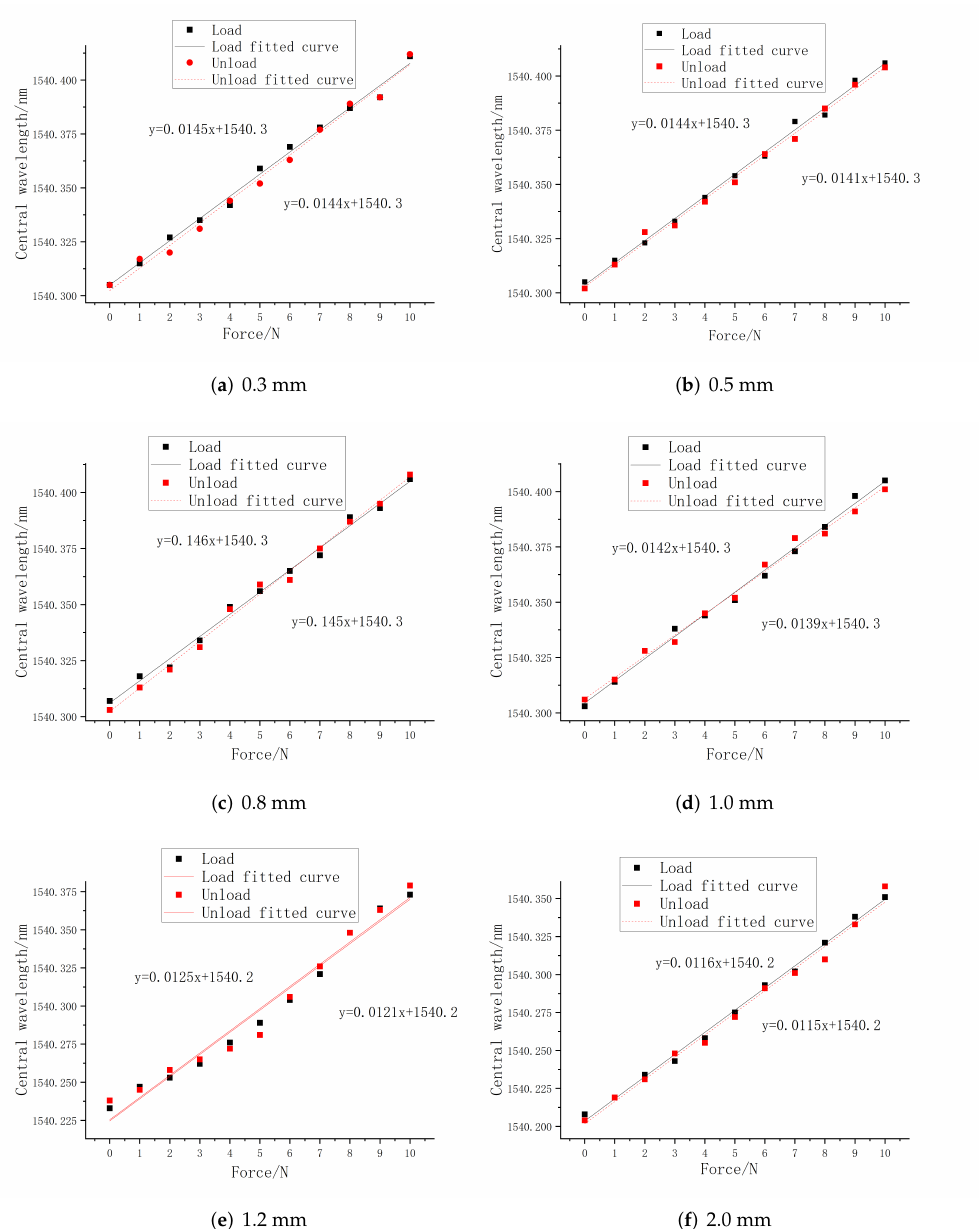
Figure 8. Loading and unloading fitting curve of